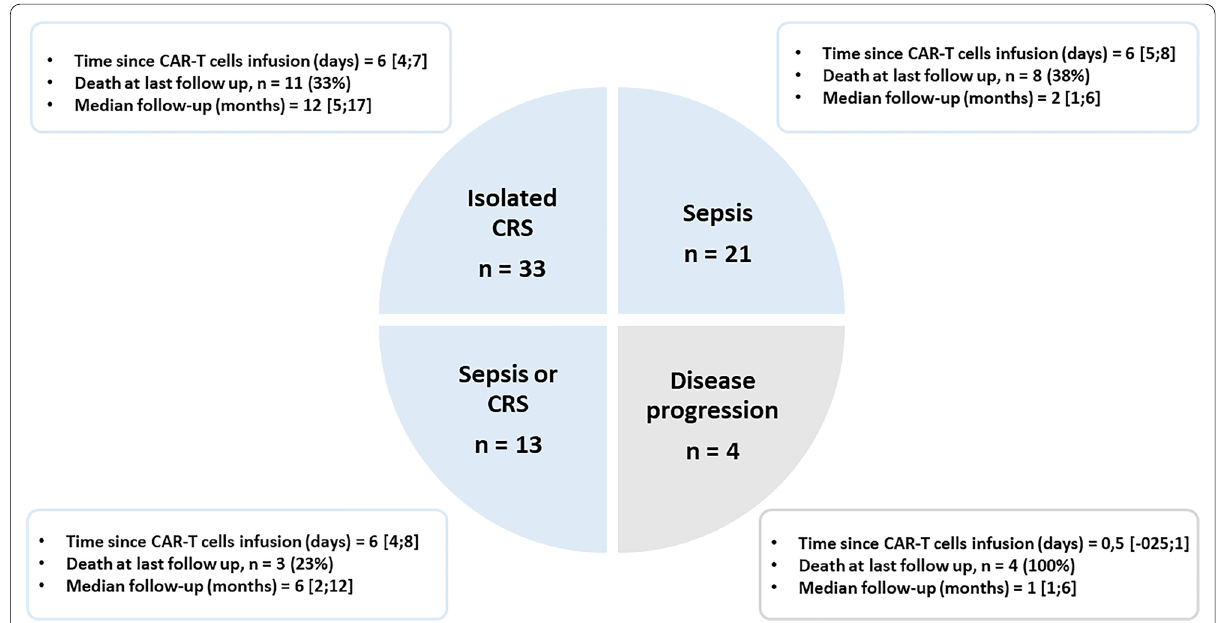
Fig. 1 Characteristics of patients according to the reason for ICU admission. CRS cytokine release